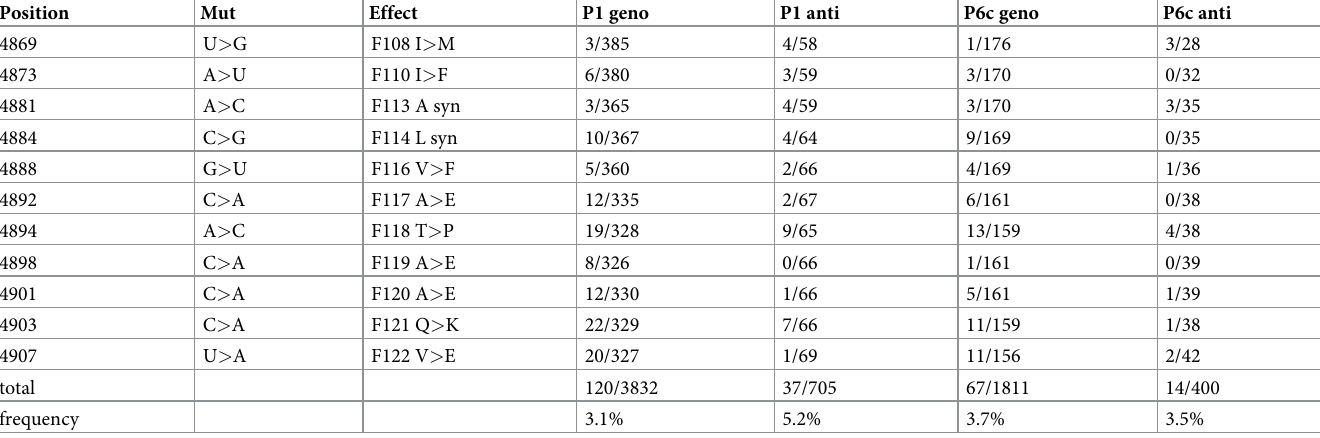
� In large capitals the residues of the fusion related external domain that are affected by the mutations and in bold those that are changed as a result of a non- synonymous